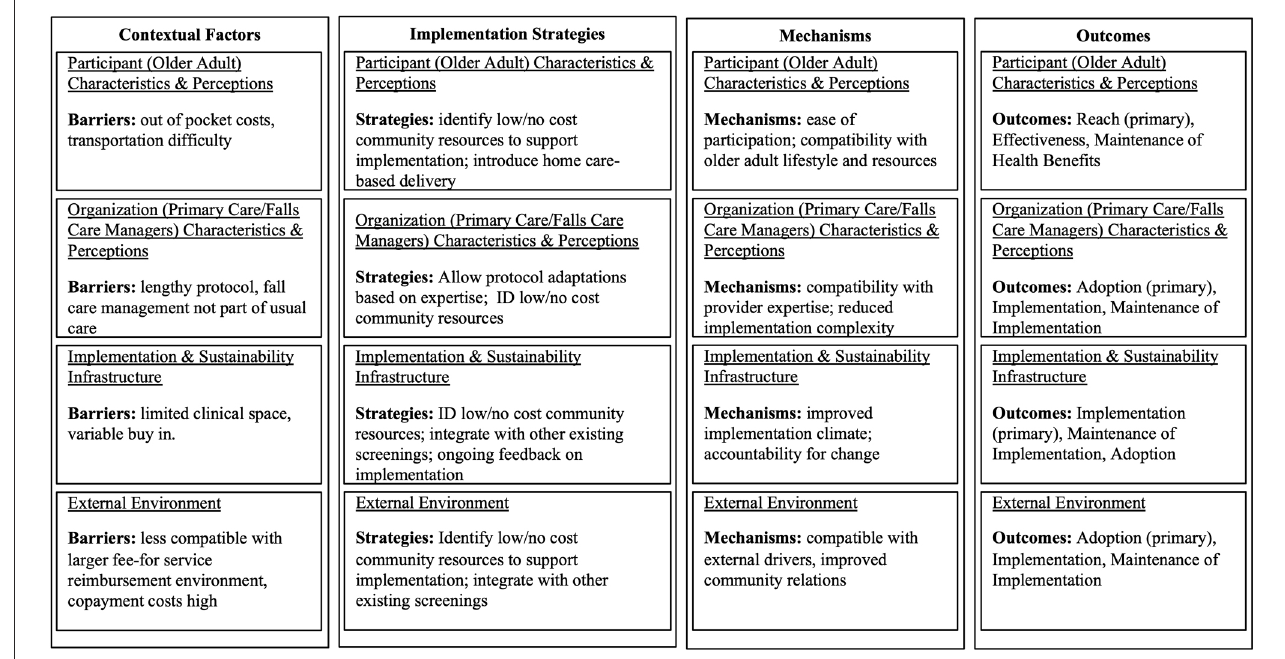
FIGURE1 An example application of dissemination and implementation science in aging research: STRIDE, a national study to prevent fall related injuries.